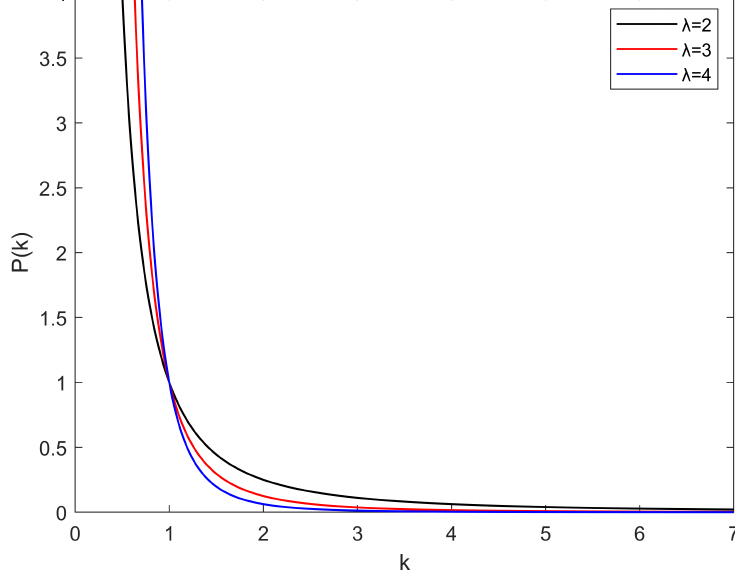
Figure 2. Power-law distribution function.